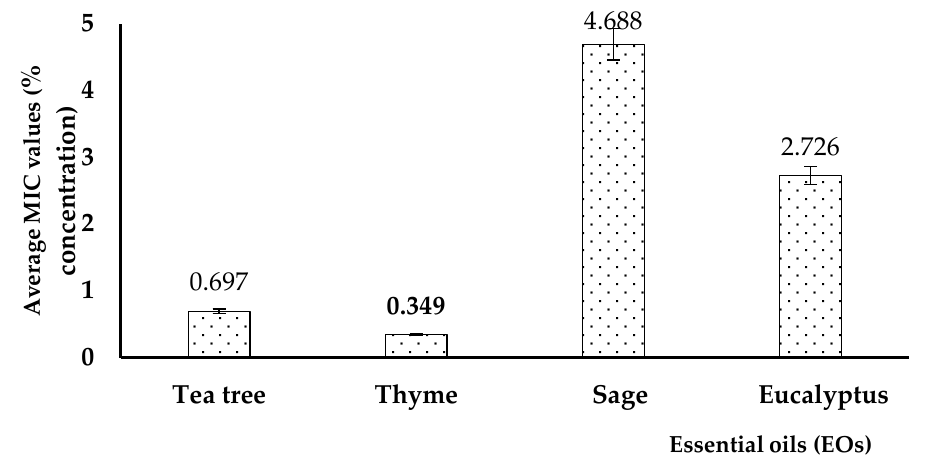
Figure 7. Average minimum inhibitory concentration (MIC) values, expressed as percent (%) concentration of the EOs in P. aeruginosa strains, regardless of their isolation source.